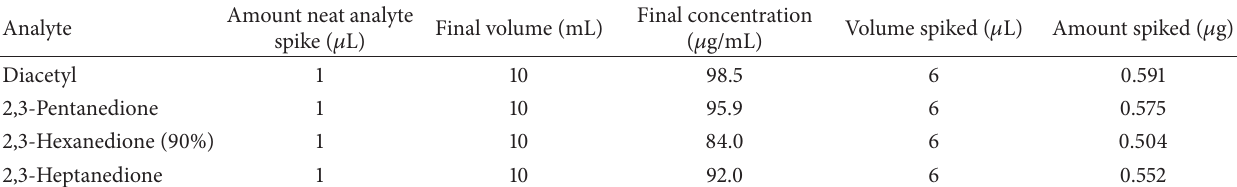
Table 2: Standard stock spiking solution preparation and spiking volumes for stability studies.